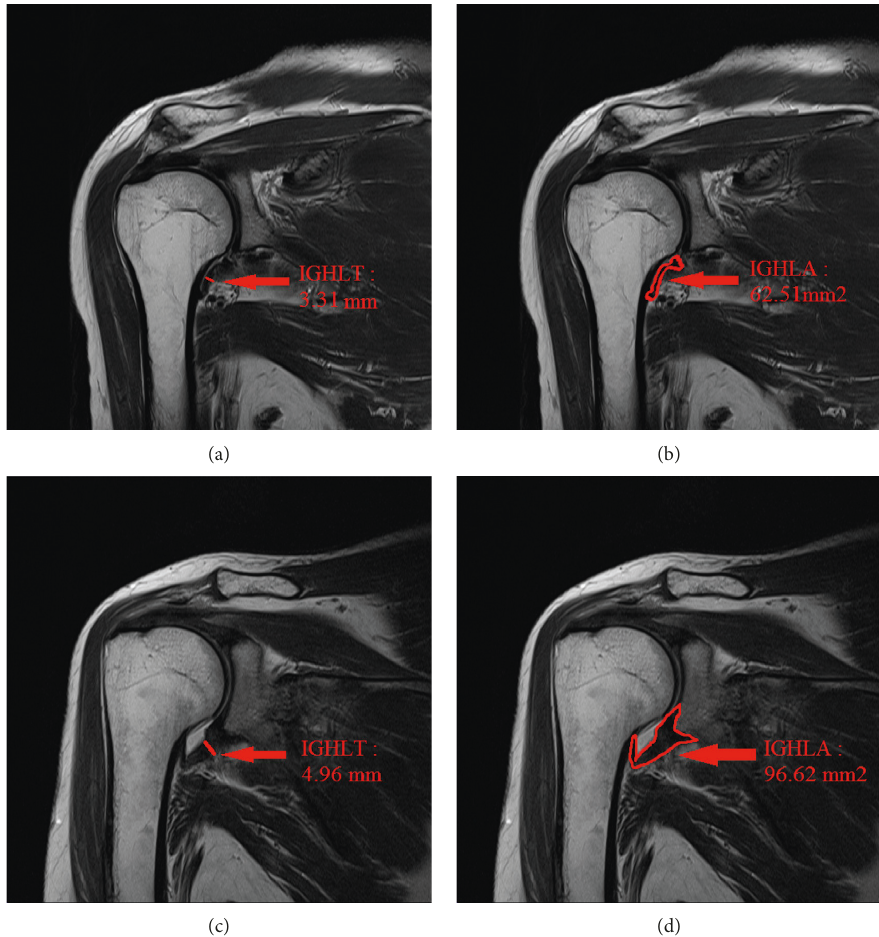
Figure 1: T2-weighted turbo-spin-echo coronal MR image in inferior glenohumeral ligament sections: (a) normal aIGHLT; (b) normal aIGHLA; (c) aIGHLTin the AC group; (d) aIGHLA in the AC group. aIGHLT � anterior band of inferior glenohumeral ligament thickness. aIGHLA � anterior band of inferior glenohumeral ligament area. AC � adhesive capsulitis.